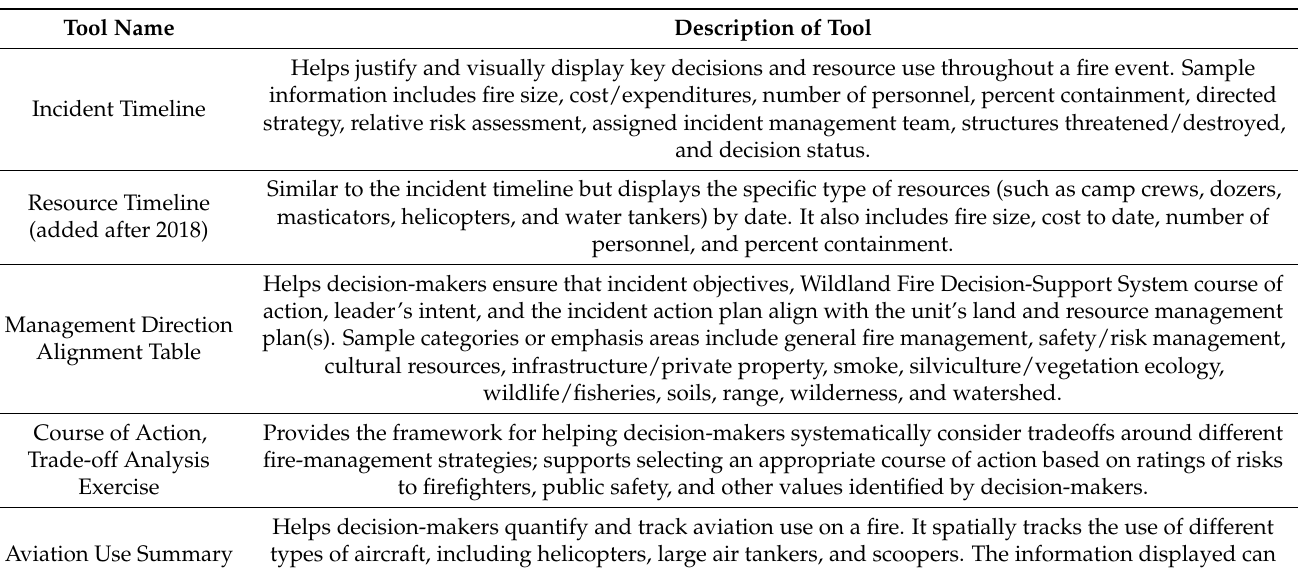
Table 1. Most common RMA tools and analytical products offered. Adapted from